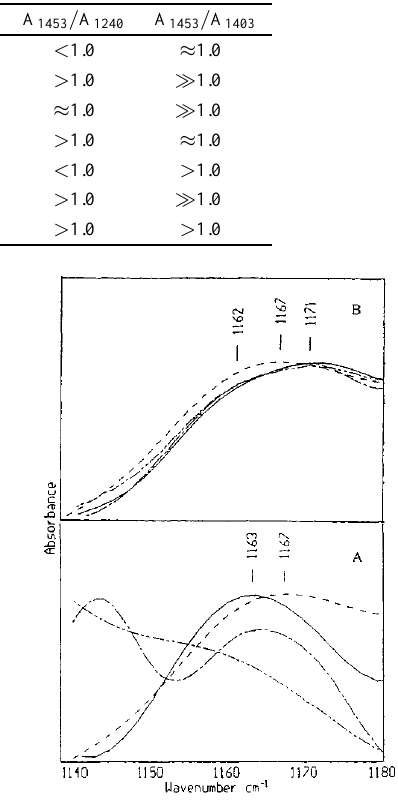
Fig. 6. This figure shows the spectral differences in the region of 1140–1180 cm (cid:0) 1 between (A) well differentiated carcinomas: (a) apocrine (—), (b) tubular (— - — -), (c) intraductal (---), (d) muci- nous (— -- — --) and (B) poorly differentiated carcinomas: (a) in- vasive infiltrating ductal (—), (b) simplex (— - — -), (c) medullary carcinoma (— -- — --), (d) intraductal (---): the band of well dif- ferentiated carcinoma emerges peaking below 1167 cm (cid:0) 1 , the band of poorly differentiated carcinoma is broader, and is composed two bands peaking at 1162 cm (cid:0) 1 and 1170 cm (cid:0) 1 . peaking at 1162 and 1170 cm (cid:0) 1 . These results may